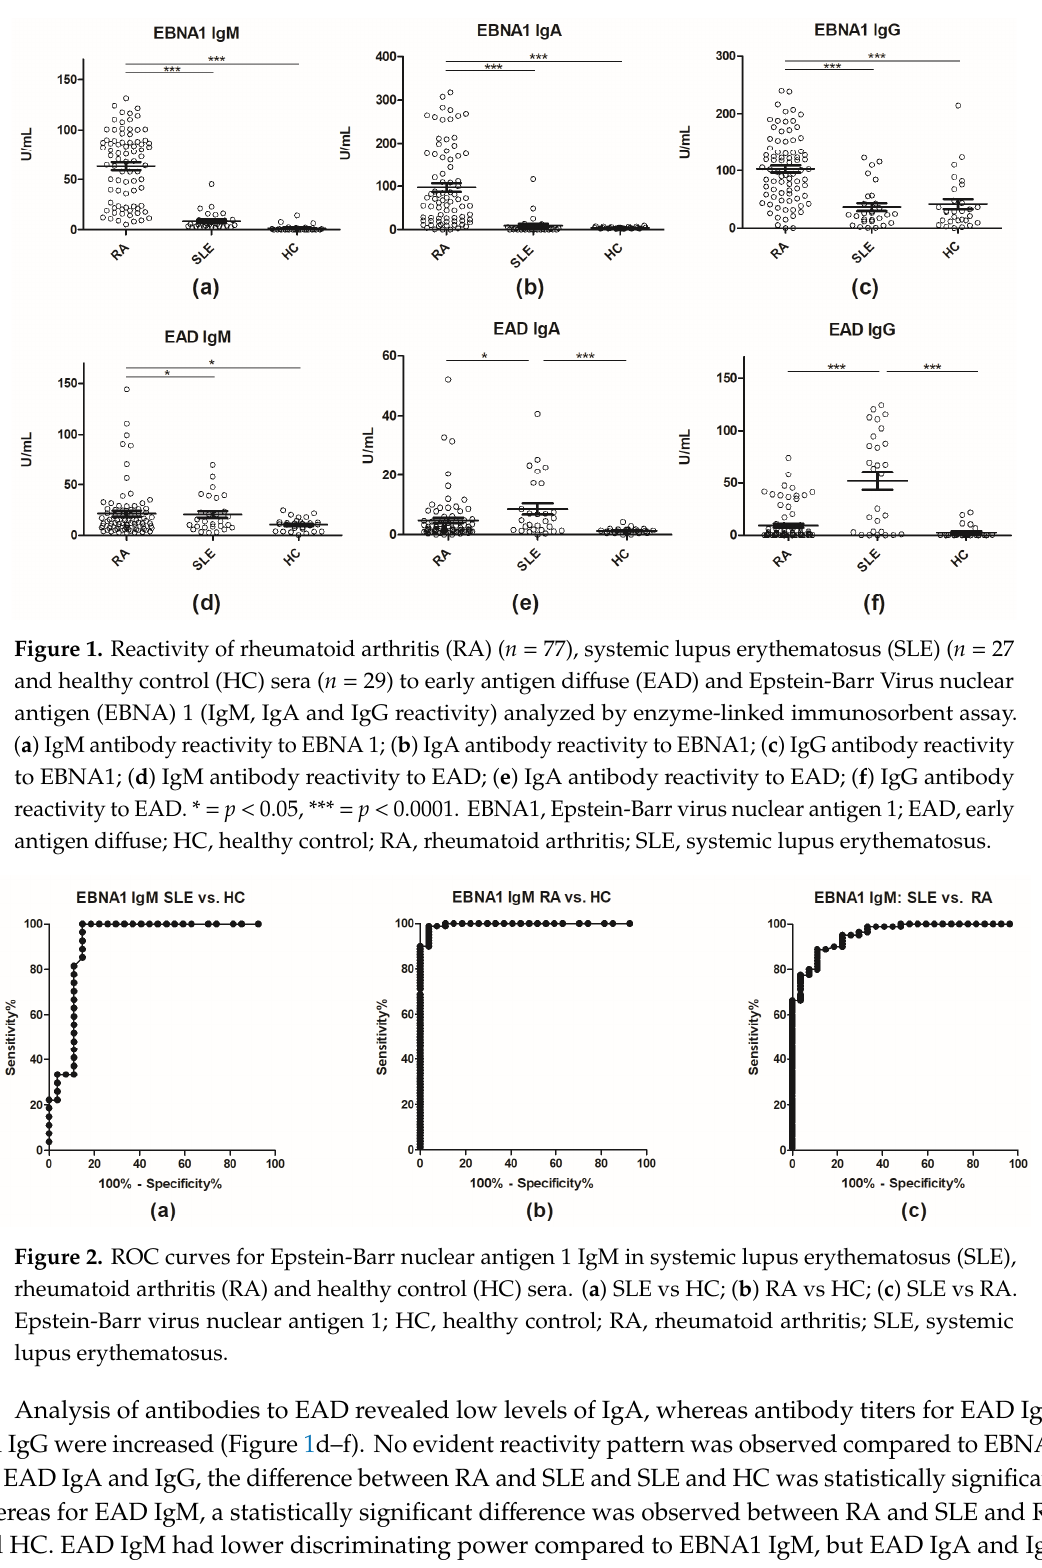
Table 1. IgG, IgA, IgM antibodies to EAD and EBNA1 in SLE ( n = 27), RA ( n = 77) and HC ( n = 29). Overview of the best discrimination test with AUC > 0.8. AUC Std. Error 95% Confidence Interval p Value